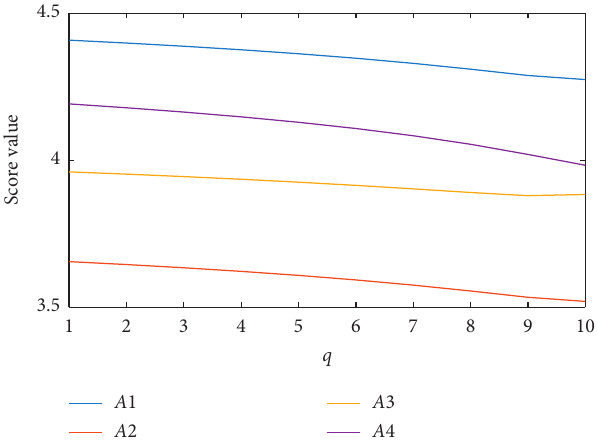
Figure 7: Scores of A ( i � 1 , 2 , 3 , 4 ) when q � 1and p ∈ [ 0 , 10 ]( θ � 5 ) . i